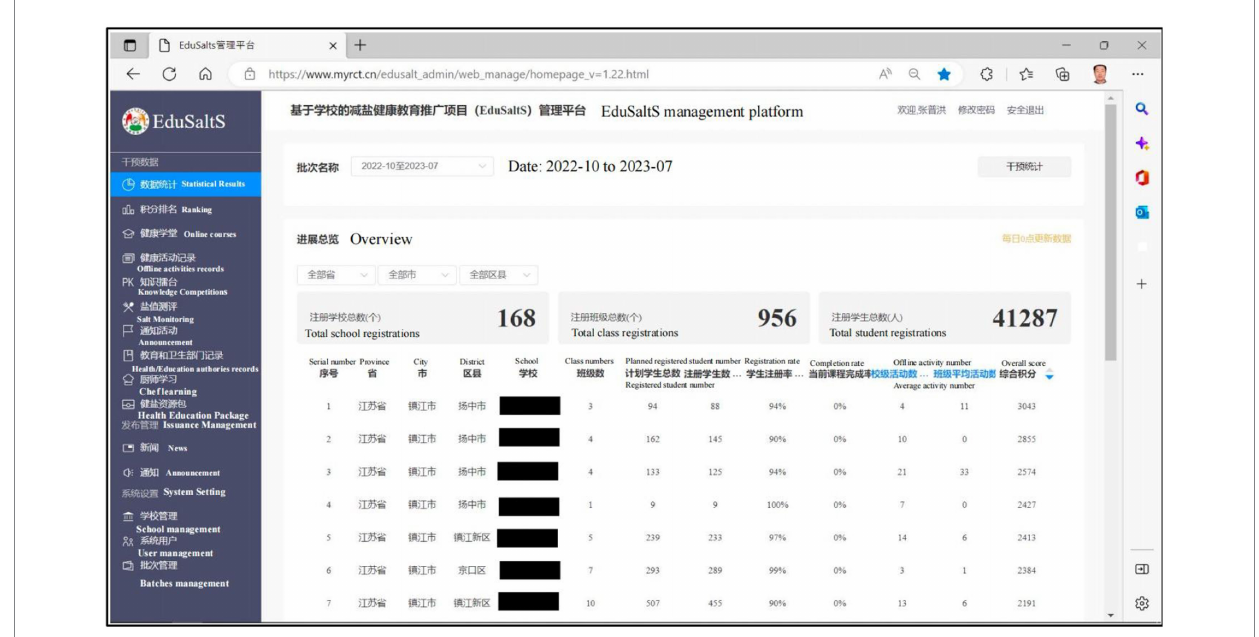
FIGURE 4 The web based of EduSaltS management platform for statistical reports and system